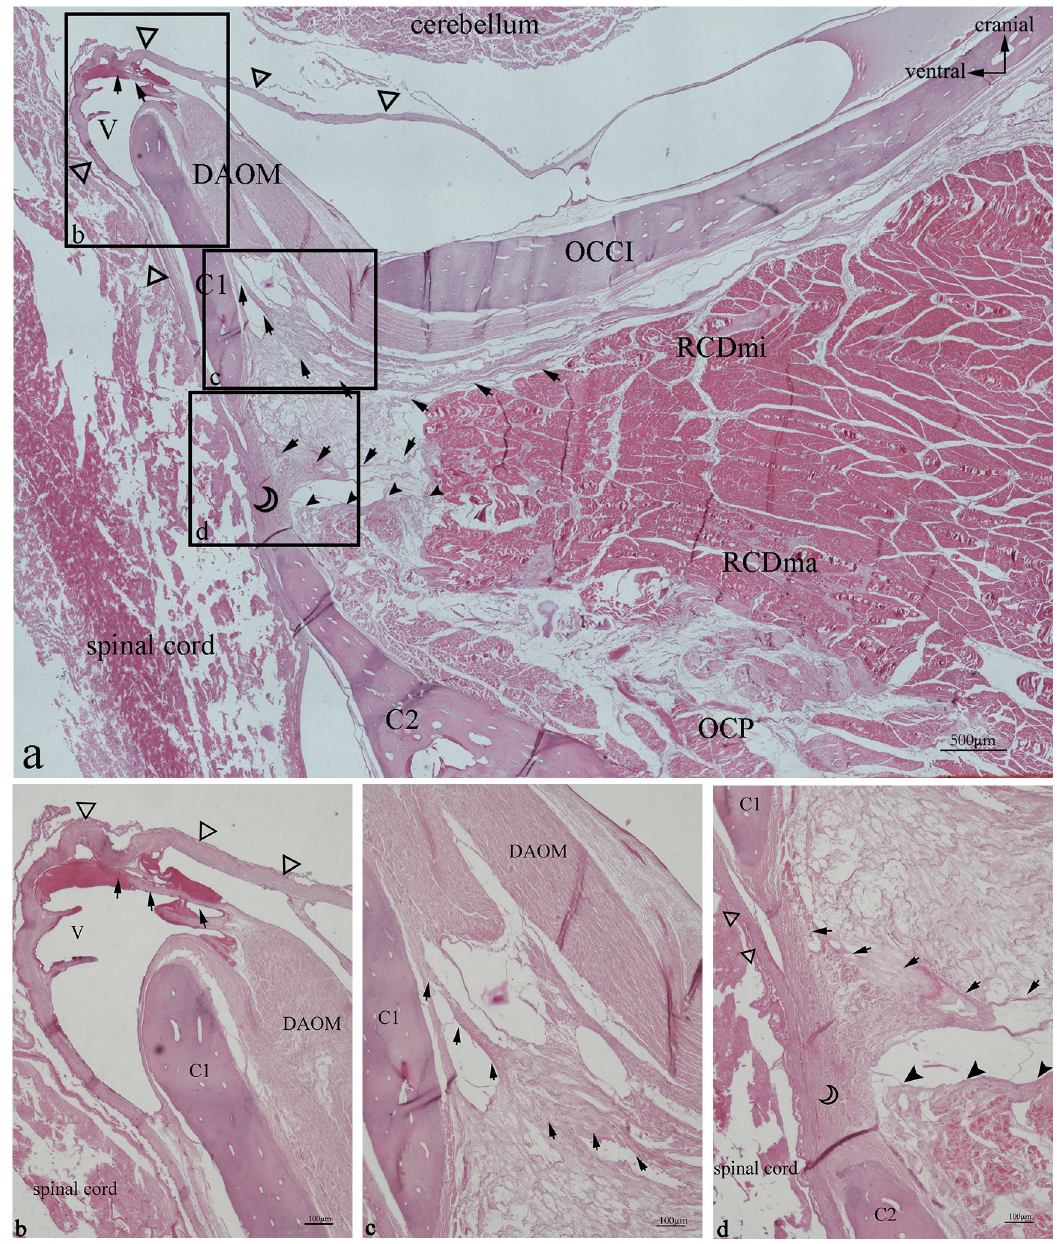
Fig 3. Gentoo penguin, prepared sagittal section of the suboccipital region with stained with HE. Area within square in a is shown enlarged in b, c, and d. The fibers (arrow) originate from the ventral anterior of RCDmi, extend directly into the atlanto- occipital interspace, then fuse with the DAOM, and the DAOM extends into a fiber bundle through the venous sinus to connect with the SDM (hollow triangle). In the atlanto-axial interspace, the dense fibers bundles (arrow) originating from the ventral side of the RCDmi run ventrally run ventrally, and integrate into the dorsal atlanto-axial membrane (hollow crescent) together with the dense fibers(filled arrowhead) originating from the RCDma and OCP, and send out dense fibers bundles to closely connect with the SDM. Abbreviation: OCCI = occipital bone; RCDmi = rectus capitis dorsalis minor muscle; OCP = oblique capitis posterior; DAOM = dorsal atlanto-occipital membrane; SDM = spinal dura mater; C1 = atlas; C2 = axial; V = venous sinus.